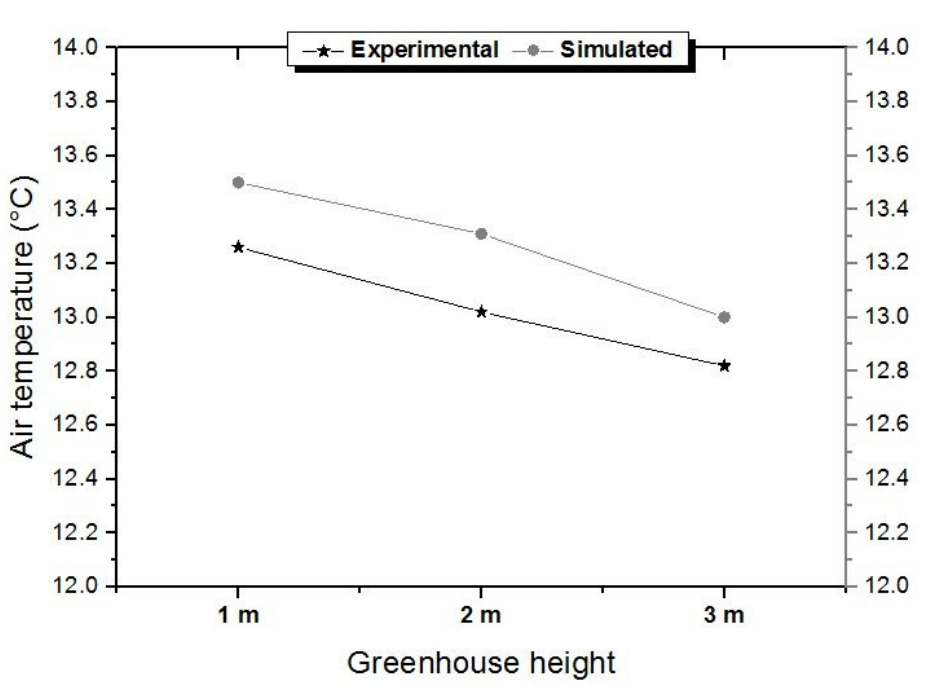
Figure 5. Evolution of simulated and measured air temperatures inside the greenhouse as a function of height (1 m, 2 m and 3 m) at midnight.